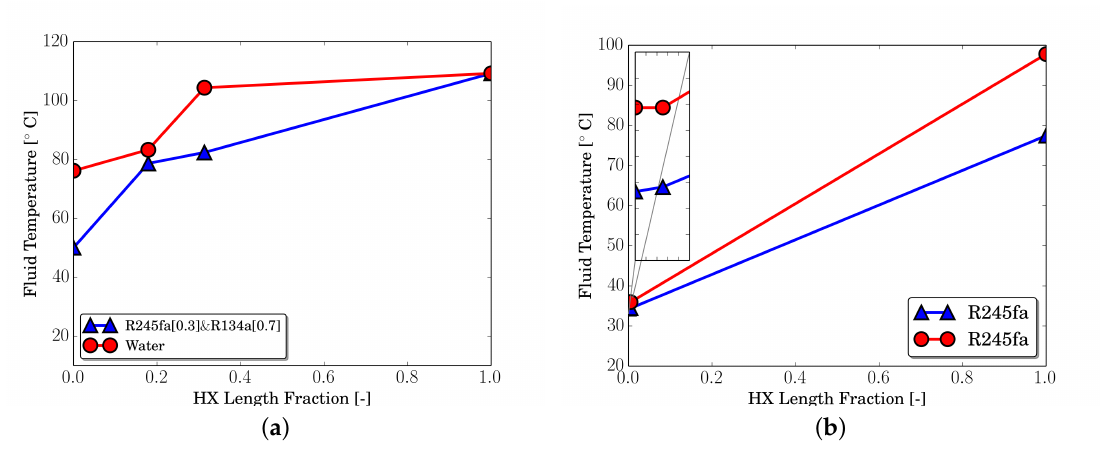
Figure 4. Examples of temperature profile across PHEX: ( a ) evaporator with zeotropic mixture and water as hot fluid; ( b ) internal regenerator with R245fa and partial condensation. The quality measured (from an energy balance over the regenerator) at the regenerator outlet prior entering the condenser is